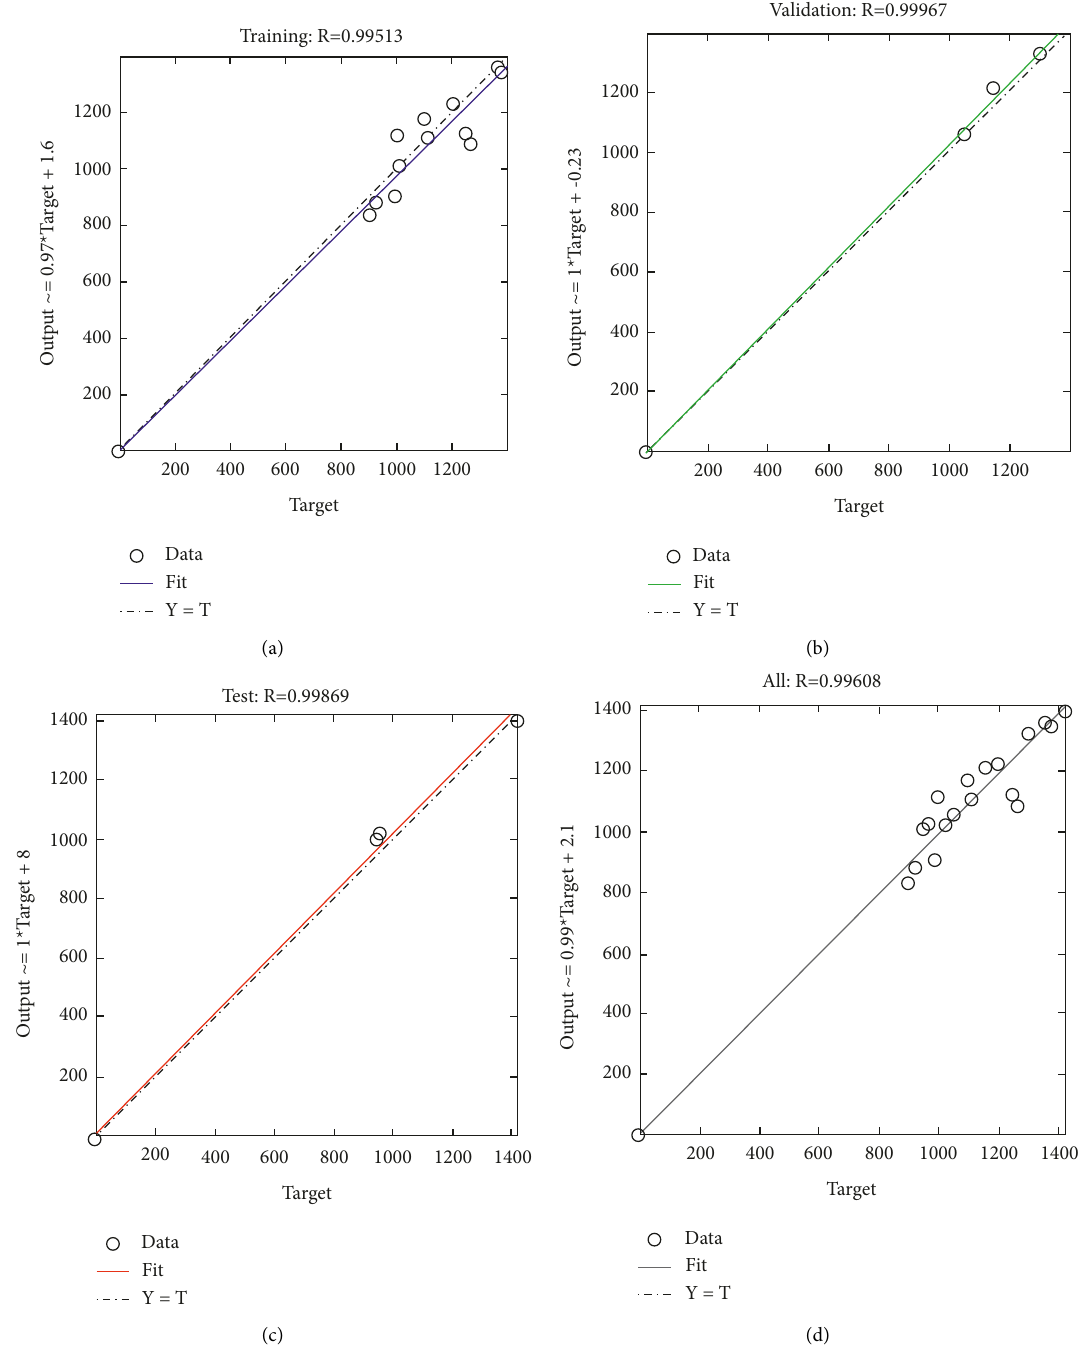
Figure 10: Regression plots of trained network w.r.t. target for (a) training, (b) validation, (c) test, and (d)